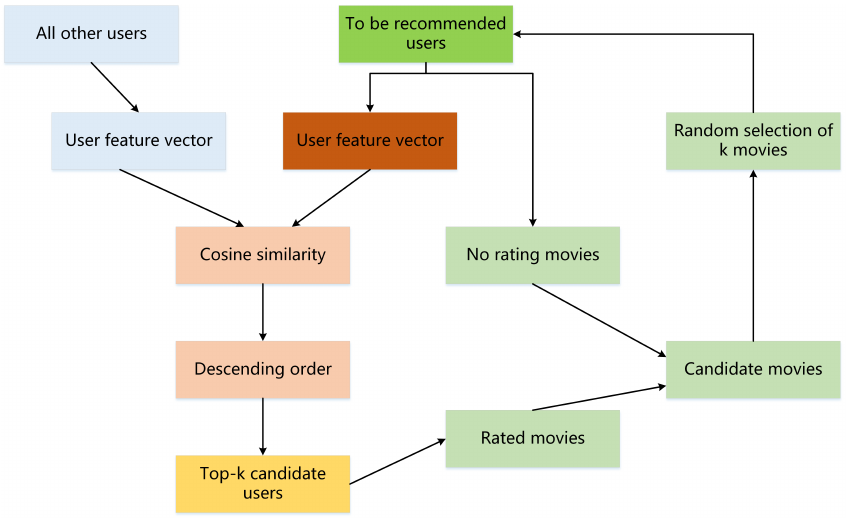
Figure 11. Scheme 2 recommended strategy